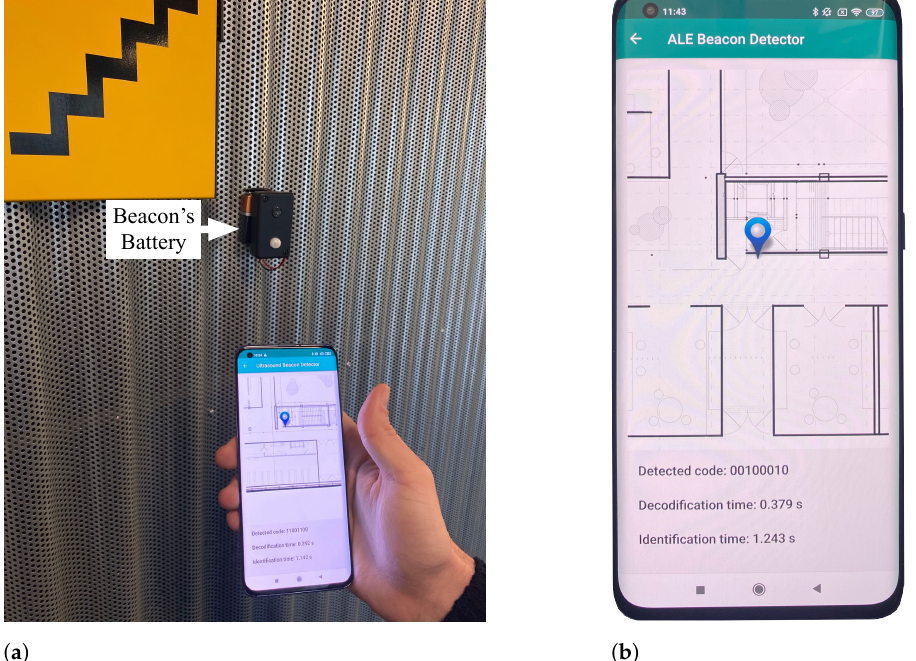
Figure 10. Field evaluation experiment. ( a ) Field evaluation experimental setup. ( b ) Android application